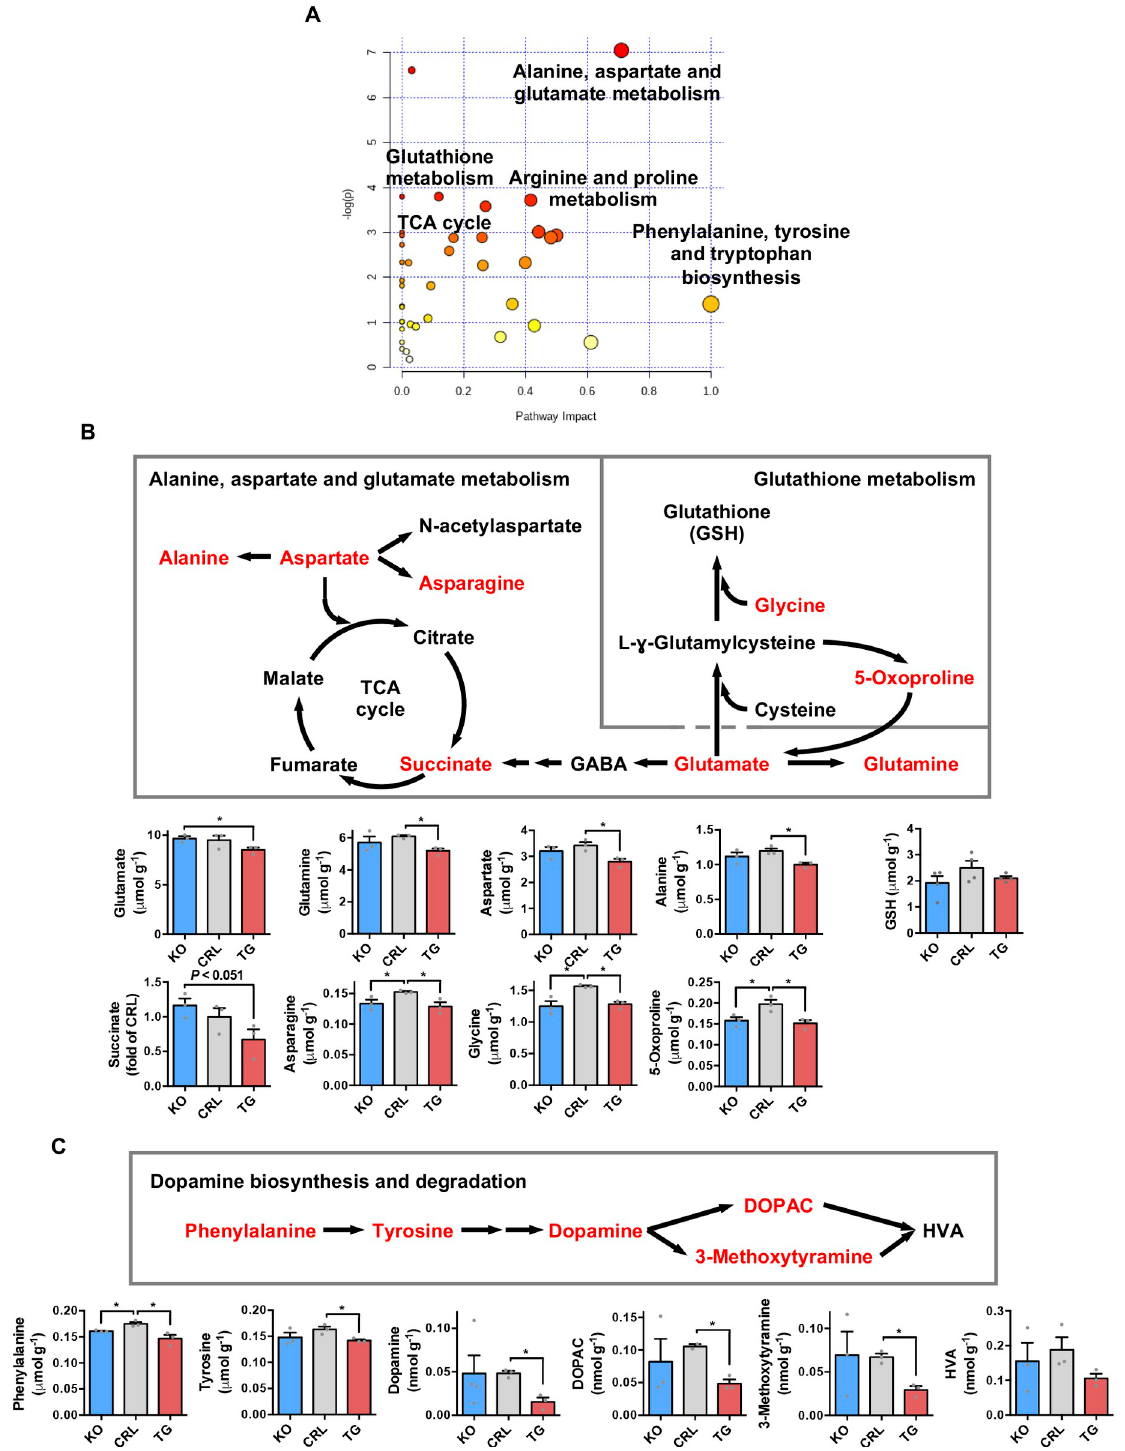
Fig 5. IF1 dose alters the metabolism of glutamate and dopamine in the hippocampus. (A) Pathway enrichment analysis of the metabolites in the comparison IF1 TG vs. IF1 KO mice. The node color is based on the P values from integrated enrichment analysis and the node radius represents the pathway impact values from topology analysis. (B) Overview of alanine, aspartate and glutamate, and GSH metabolic pathways. Metabolites significantly reduced in IF1 TG vs. CRL mice are shown in red, and their quantification is shown to the bottom ( n = 3). (C) Schematic of the biosynthesis and degradation of dopamine. Metabolites significantly reduced in IF1 TG vs. CRL mice